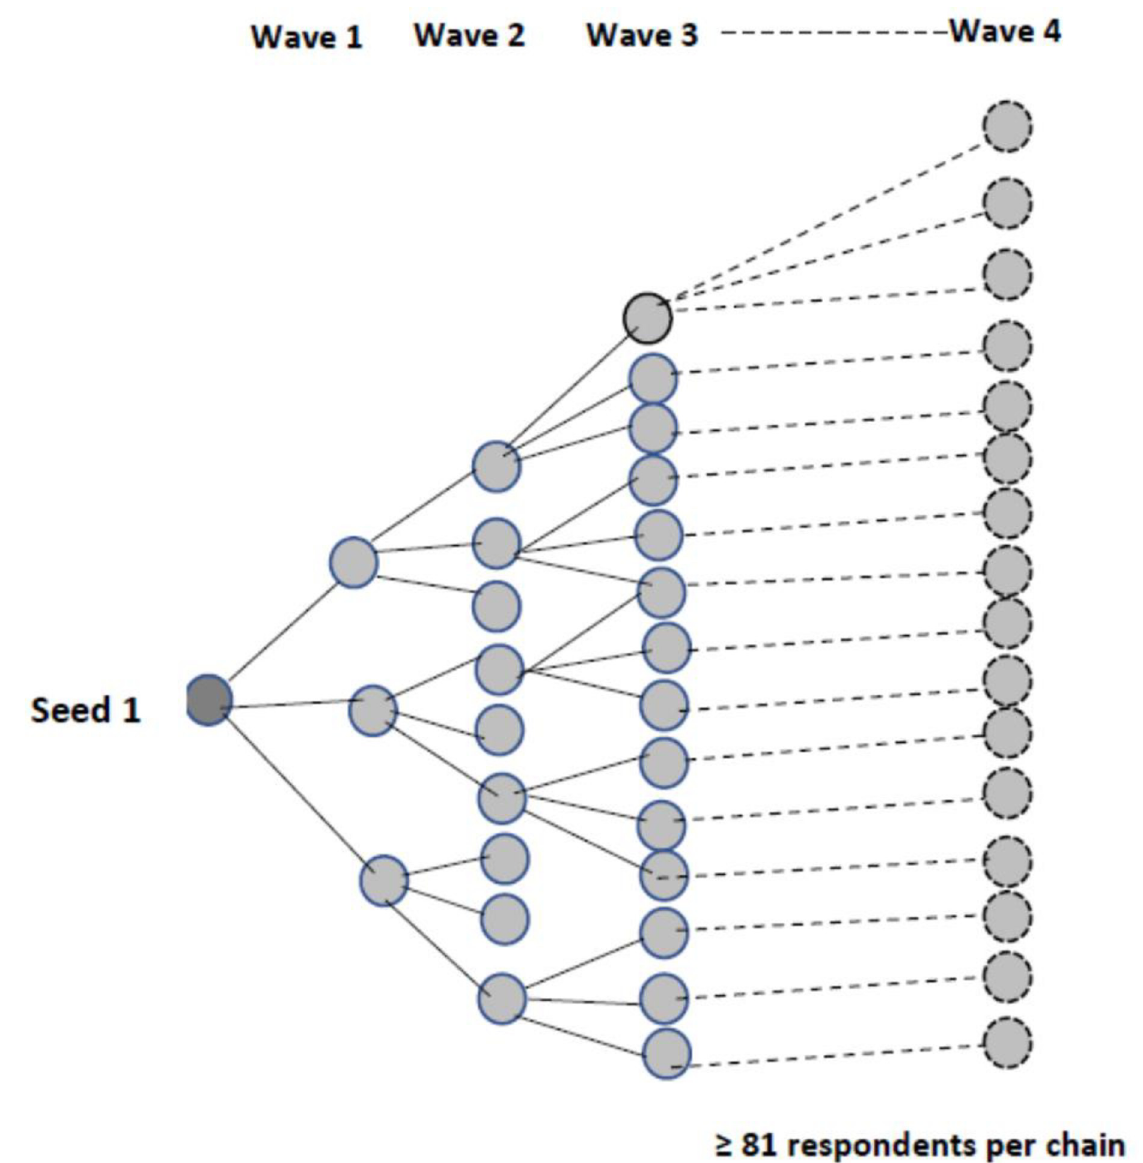
Fig 1. Example of the recruitment process for study participants using